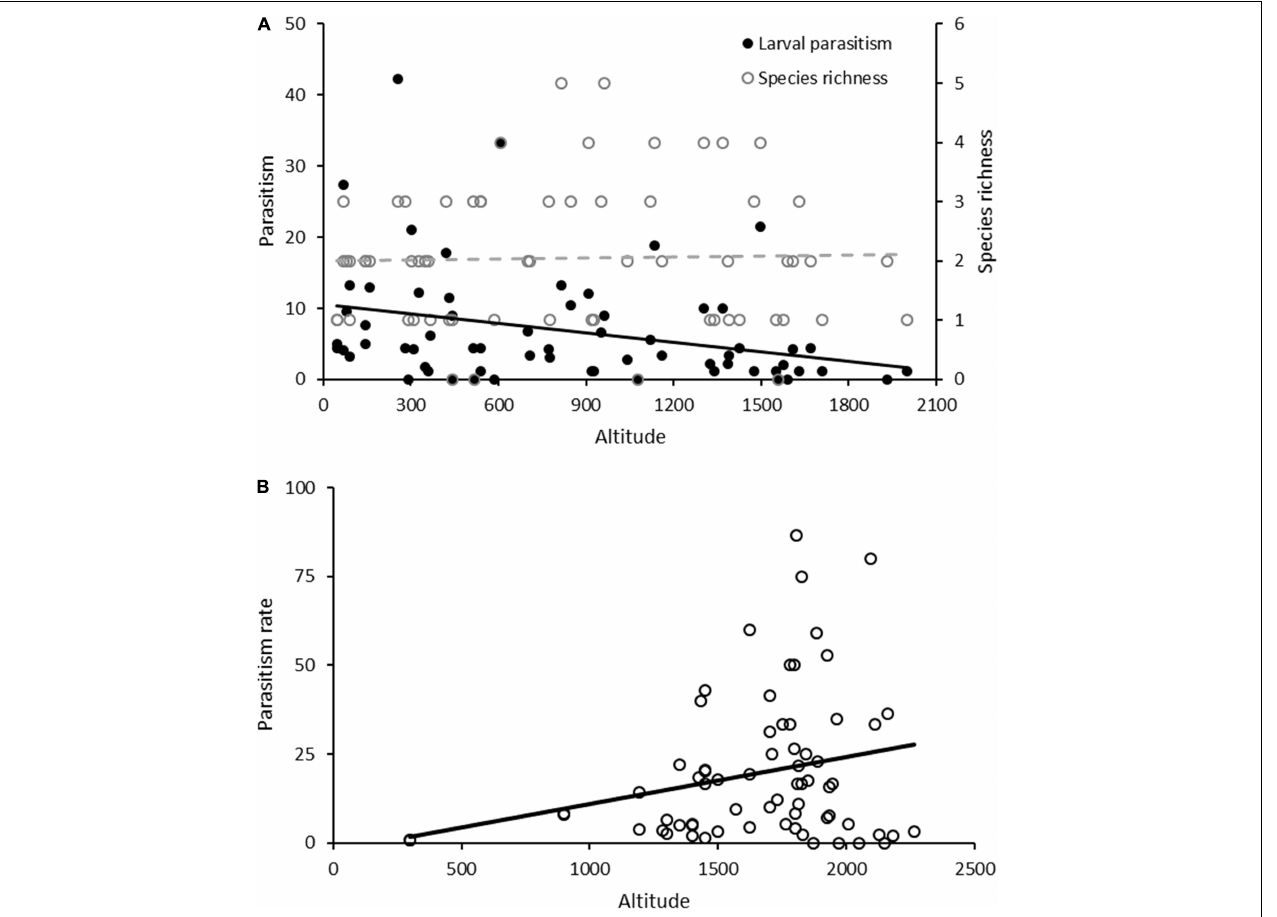
FIGURE 2 | Parasitism rates are differentially affected by altitude, for two prime sets of agricultural pests in Neotropical mountain ranges. (A) Shows parasitism rates of the fall armyworm Spodoptera frugiperda on major cereal grains in six Mexican states, by a complex of 13 parasitoid (morpho-)species. Parasitism steadily declines with elevation [ F ( 1 , 62 ) = 6.231, p = 0.015, R 2 = 0.091], while parasitoid richness remains unaffected [ F ( 1 , 62 ) = 0.047, p = 0.829]. (B) Reveals parasitism levels of a (multi-species) complex of Tephritid fruit flies in Andean mountain settings. Although overall parasitism increases with altitudinal elevation [ F ( 1 , 66 ) = 4.19, p = 0.045, R 2 = 0.060], values appear to decline rapidly at altitudes above 2,000